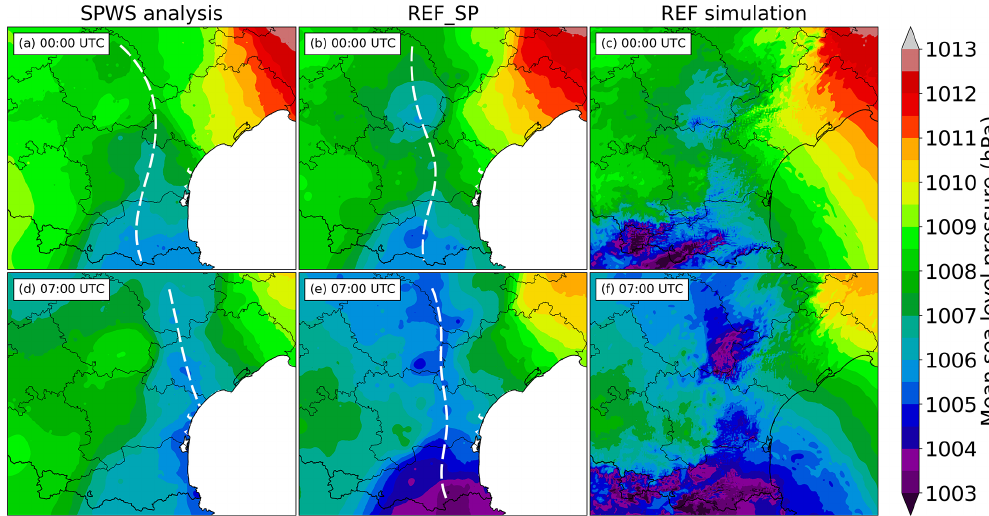
Figure 7. Mean sea level pressure on 15 October at (a–c) 00:00UTC and (d–f) 07:00UTC from (a, d) the SPWS analysis, (b, e) REF_SP and (c, f) the REF simulation. Solid black lines indicate French departments and country borders. Dashed white lines indicate the approx- imate location of the MSLP trough. Analyses are not computed over the Mediterranean Sea (in white) because of the lack of near-surface observations over the sea.